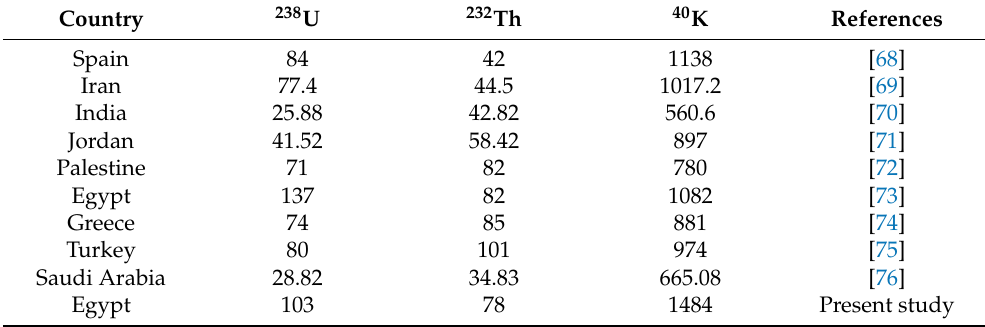
Table 5. Normality test using Kolmogorov – Smirnov.